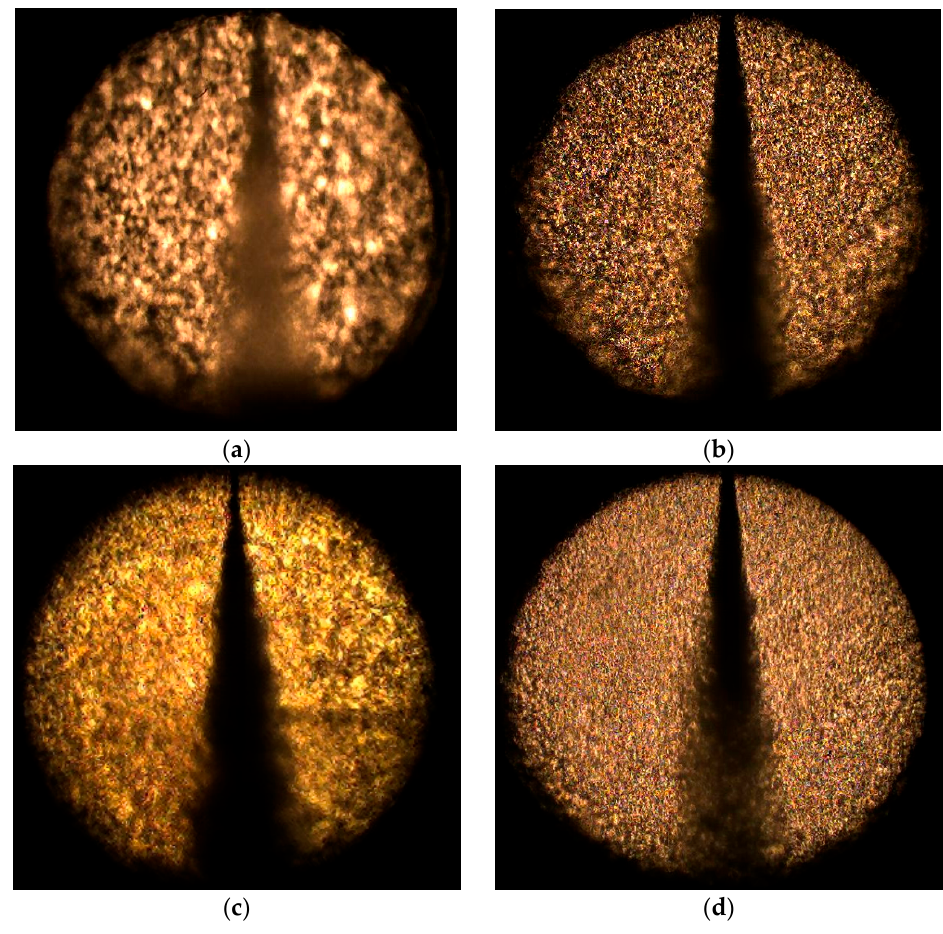
Figure 9. Series of spray events of LCO 2 -water mixture reported at different chamber pressures with same injection pressure (75 bar): ( a ) 70 bar; ( b ) 60 bar; ( c ) 50 bar; and ( d ) 30 bar.